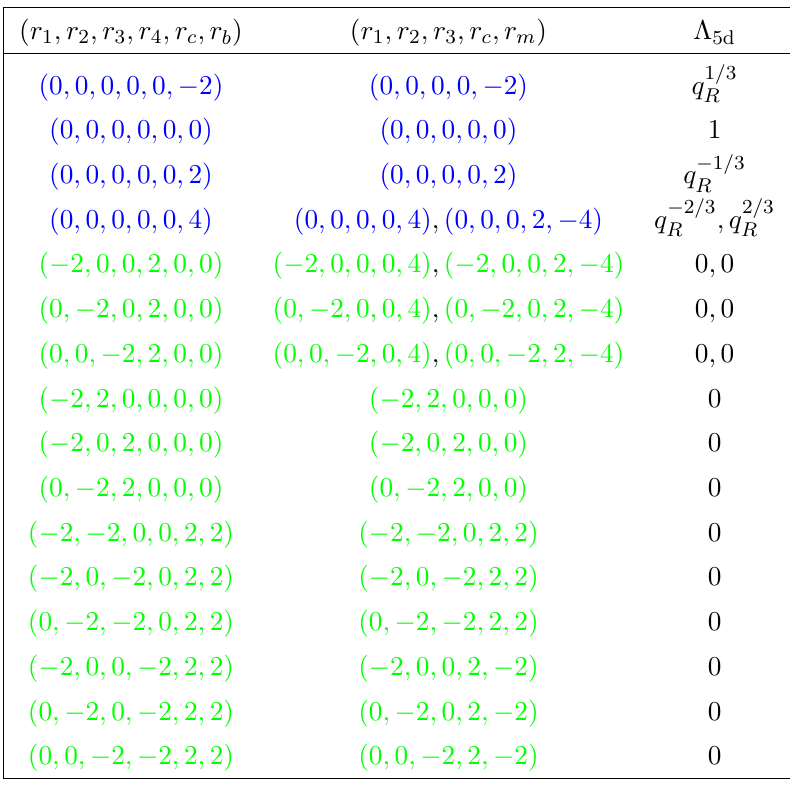
for the SO(8) model. 5d